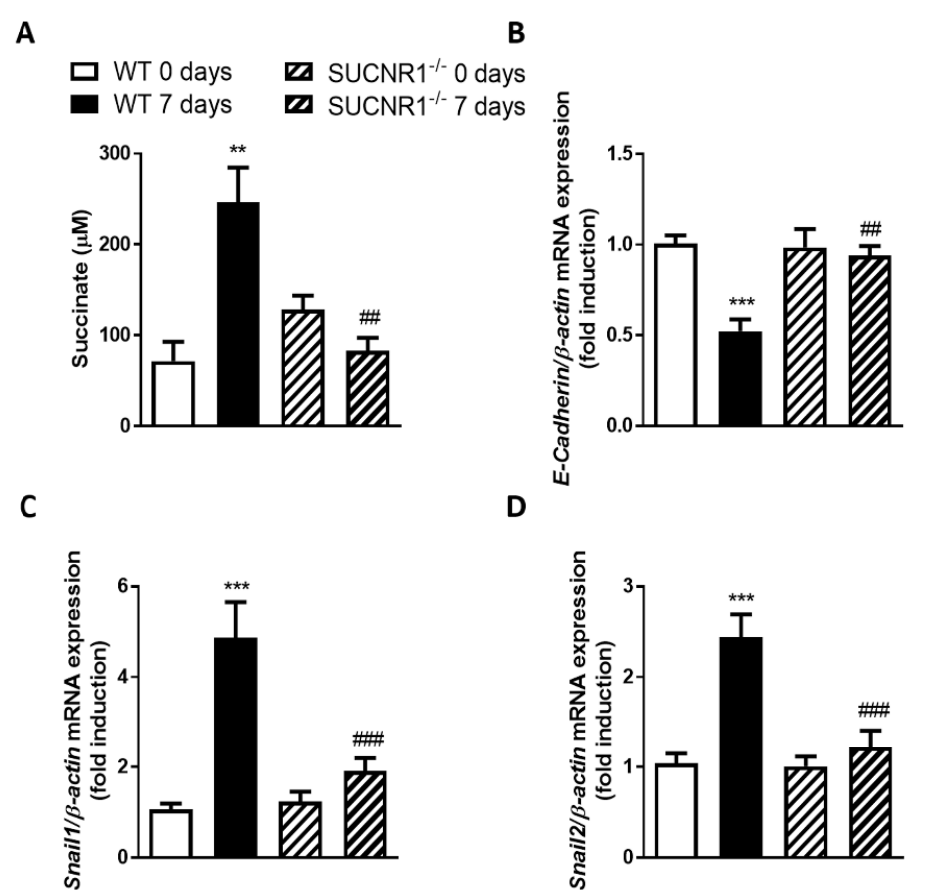
Figure 1. Lack of SUCNR1 decreases epithelial-to-mesenchymal transition (EMT) activation in vivo. Intestinal fibrosis was induced in vivo using the heterotopic transplant model. ( A ) Graph shows succinate levels in the intestinal grafts from wild type (WT) and SUCNR1 − / − mice ( n = 4). ( B – D ) Graphs show the expression of E-Cadherin, Snail1 and Snail2 in intestinal grafts from WT and SUCNR1 − / − mice ( n = 7). Bars in graphs represent mean ± SEM, and significant differences vs. intestinal grafts from WT at day 0 are shown by ** p < 0.01 and *** p < 0.001, and vs. intestinal grafts from WT at day 7 are shown by ## p < 0.01 and ### p < 0.001.